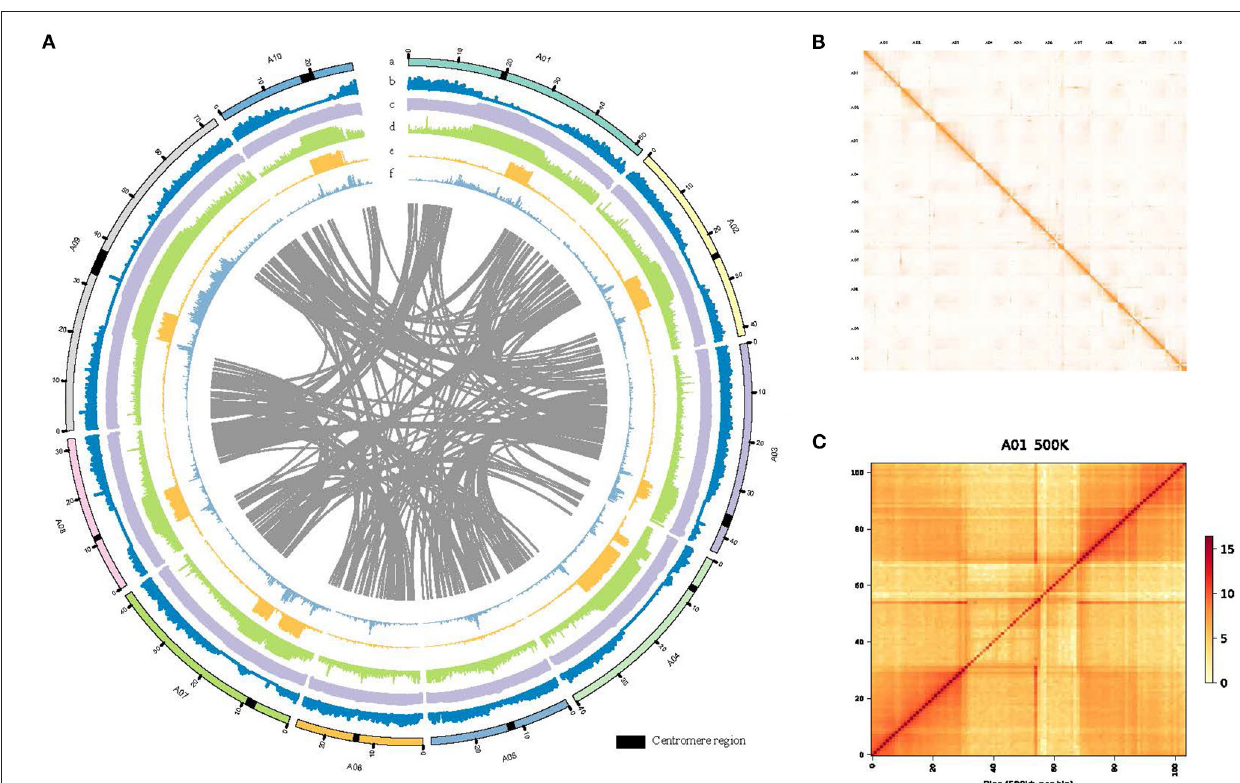
FIGURE 1 | De novo genome assembly and annotation of B.rapa “Longyou-7” genome. (A) Global view of genome features of B. rapa “Longyou-7,” Track a shows the 10 pseudochromosomes of B. rapa “Longyou-7” denoted by different colors. Track b shows the genome-wide distribution of Gene density. Track c shows the density distribution of GC content. Track d displays the density distribution of transposable elements (TE). Track e shows the density distribution of Copia. Track f shows the density distribution of Gypsy. The red triangles represent the location of the centromeres in all chromosomes; (B) Genome-wide Hi-C contact matrix of B. rapa “Longyou-7” genome; (C) Hi-C map of contact between two 500kb loci in A01 of B. rapa “Longyou-7” genome.